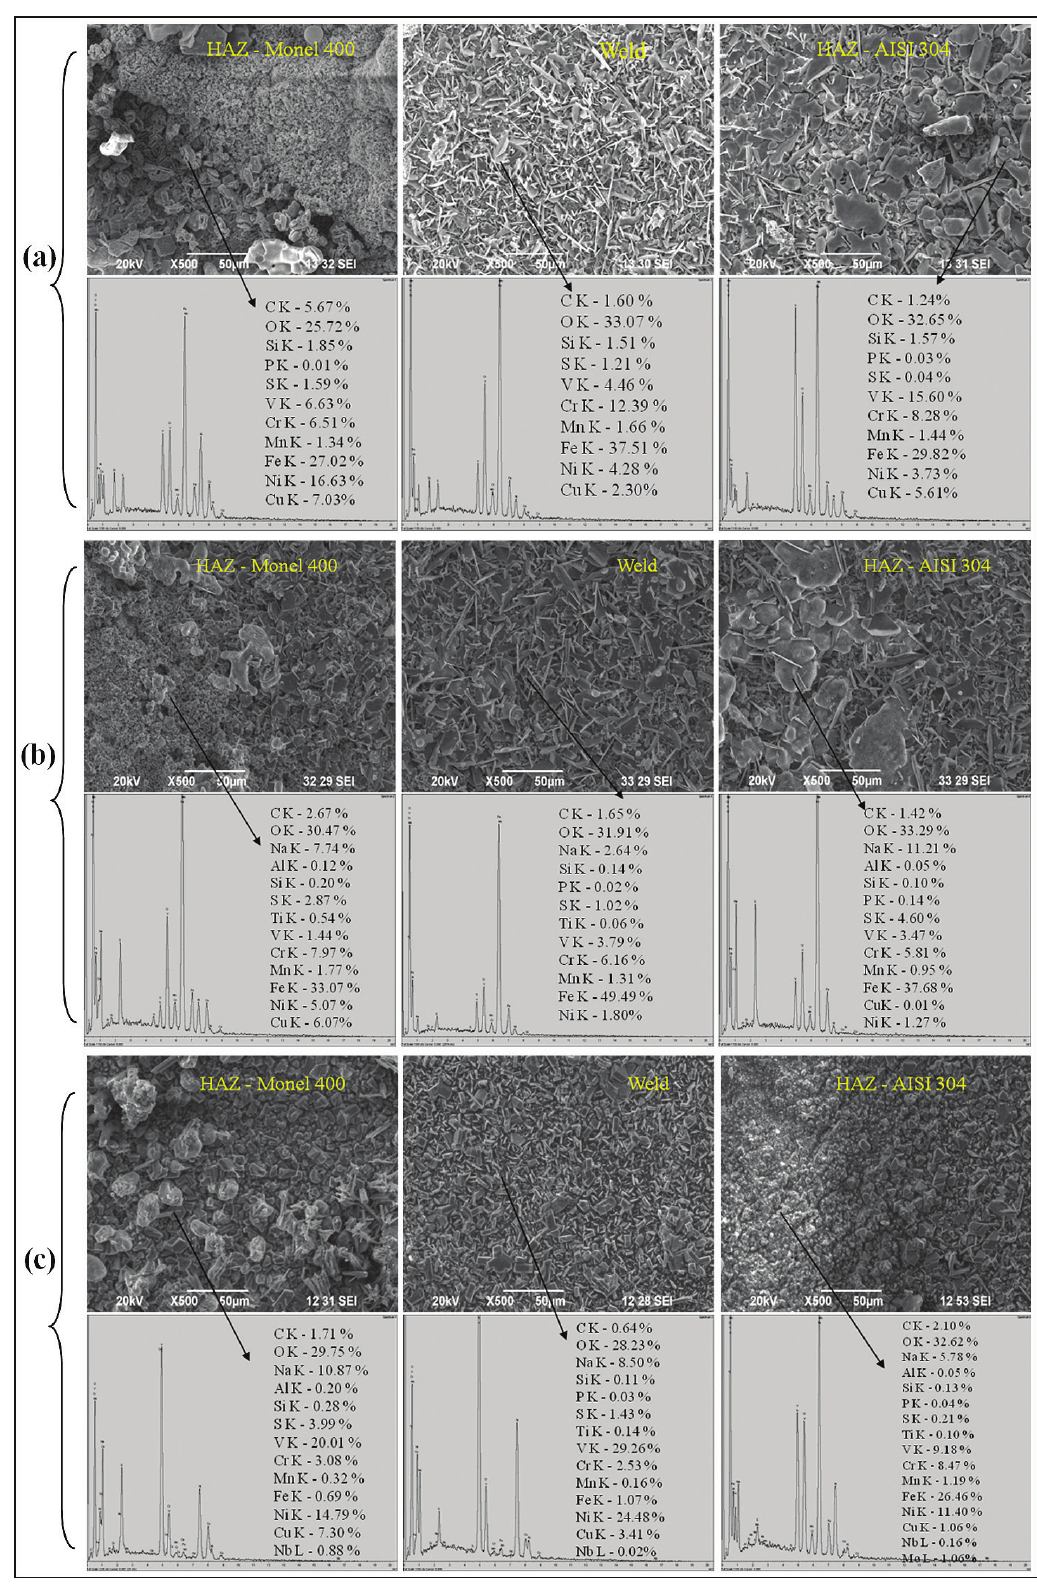
Figure 10. SEM/EDAX analysis of hot corroded PCGTA welded dissimilar Monel 400 and AOSO 304 (Composite Region) employing (a) ER309L (b) ERNiCu-7 and (c) ERNiCrFe-3 filler wires subjected to Na